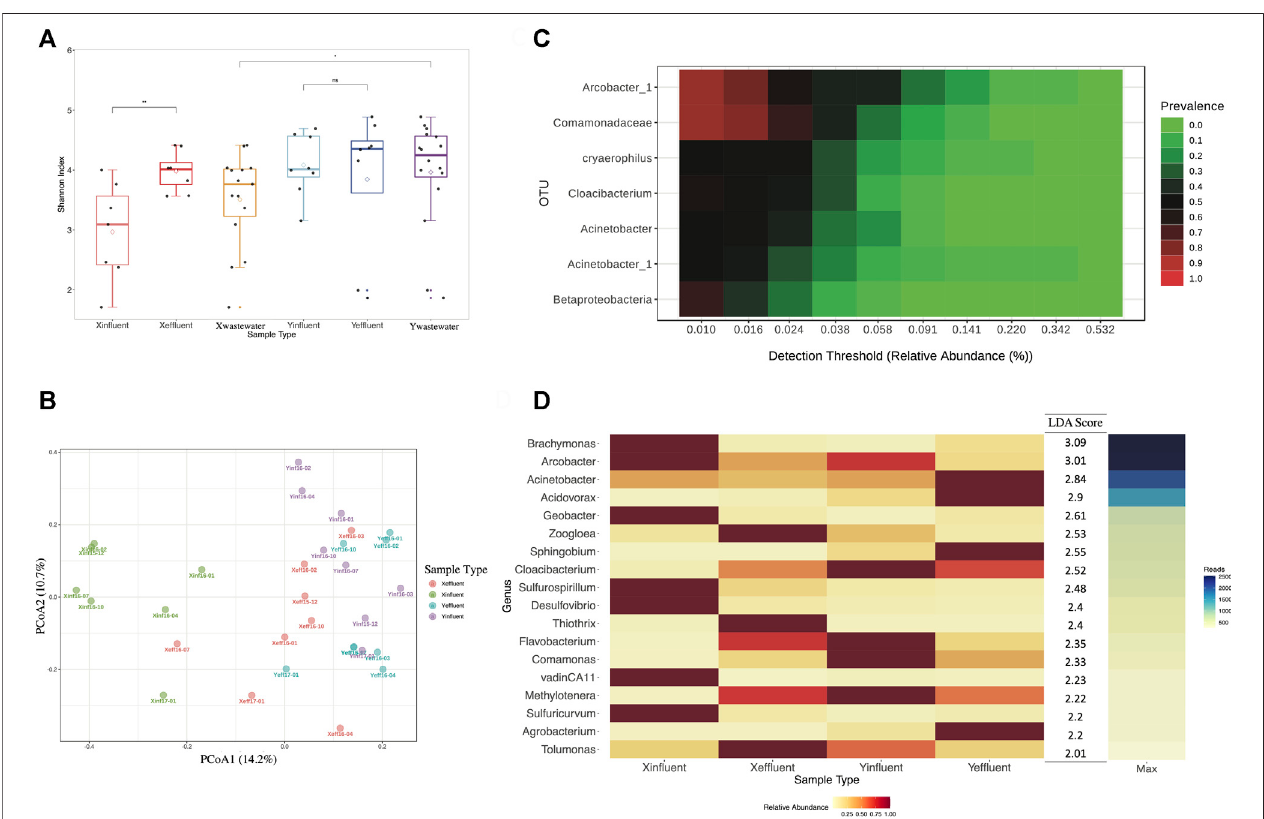
FIGURE 2 | Microbial community composition analysis of wastewater samples at OTU level. (A) SHDI of wastewater samples. (B) PCoA of wastewater samples based on Bray-Curtis Index. (C) Core Microbiome analysis of wastewater samples. (D) LEfSe analysis of wastewater samples.